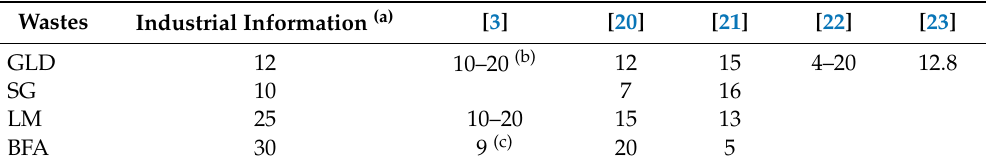
Table 1. Specific waste generation in kraft pulp mills (kg / t AD). Wastes Industrial Information (a)